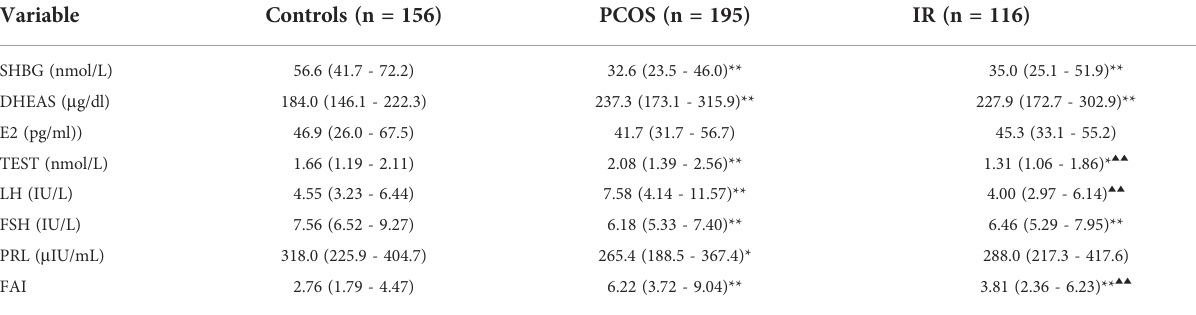
FAI, freeandrogenindex; LH, luteinizing hormone; FSH, follicle-stimulating hormone; DHEA-S, dehydroepiandrosterone-sulfate; SHBG, sex hormone-binding globulin; TEST, testosterone; E2, estrogen. Values were given as means ± SEM or median (interquartile Range). *p < 0.05, **p < 0.01 compared with Controls; ▴▴ p < 0.01 compared with To explore the predictive effect of GPHB5 on IR and PCOS, tertile 4, > 3.96 m g/L for PCOS). When the circulating GPHB5 we performed ROC curve analysis. The results showed that the concentration was in tertiles 2, 3 and 4, the odds ratios (ORs) of best cut-off value for circulating GPHB5 to predict IR was 3.51 having IR and PCOS were 13.2 (95% con fi dence interval (CI), Figure 6G), and to predict PCOS was 2.37 m g/L (sensitivity for IR (Figure 6E), and 12.10 (95% CI, 2.71; 2.83), 17.3 (95% CI, 3.44; 3.64) and 135 (95% CI, 4.59; 4.80) for PCOS (Figure 6F).